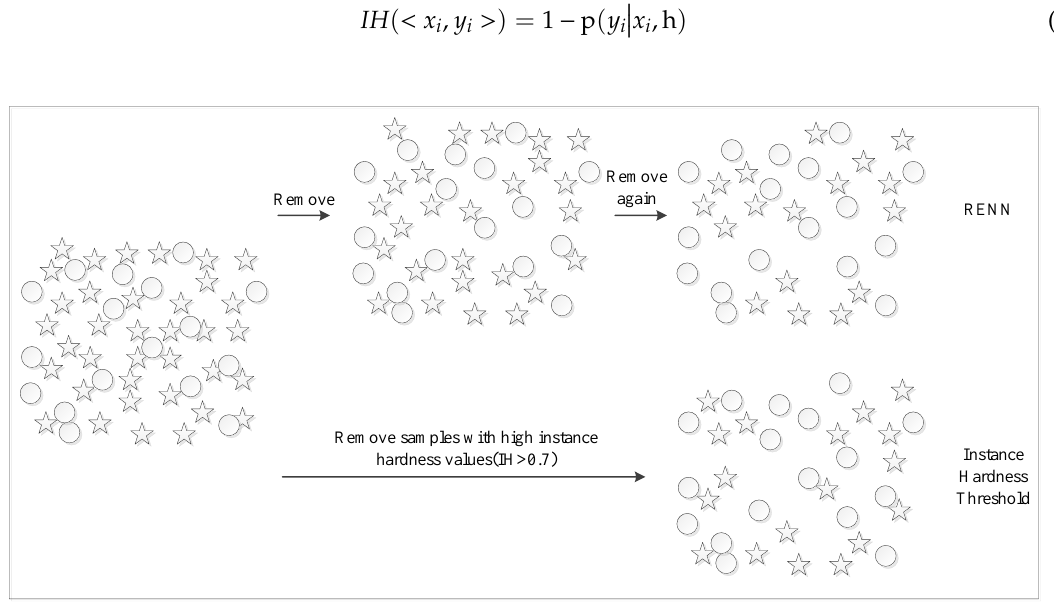
Figure 4. RENN and IHT algorithm schematic. Herein, the circles denote the positive samples, and the stars are negative ones.